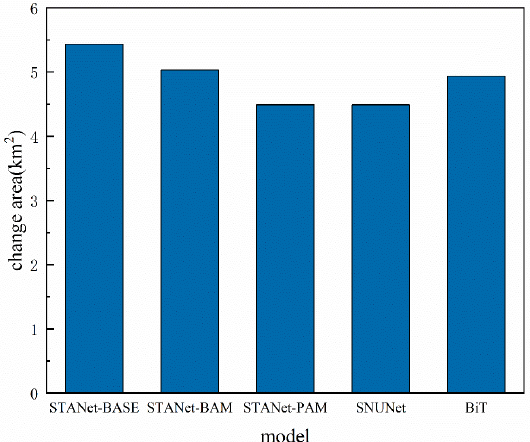
Figure 7. The total areas of new construction of the Core Region of Jiangbei New Area from 2015 to 2021, detected by STANet ‐ BASE, STANet ‐ BAM, STANet ‐ PAM, SNUNet, BiT.